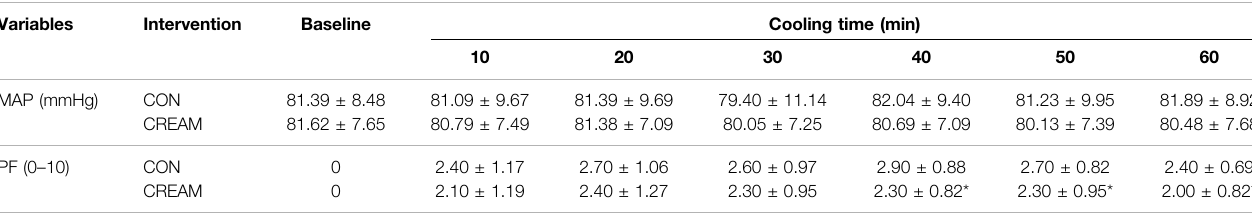
TABLE 2 | Mean arterial pressure (MAP) and perception of frostiness (PF) in study 1.